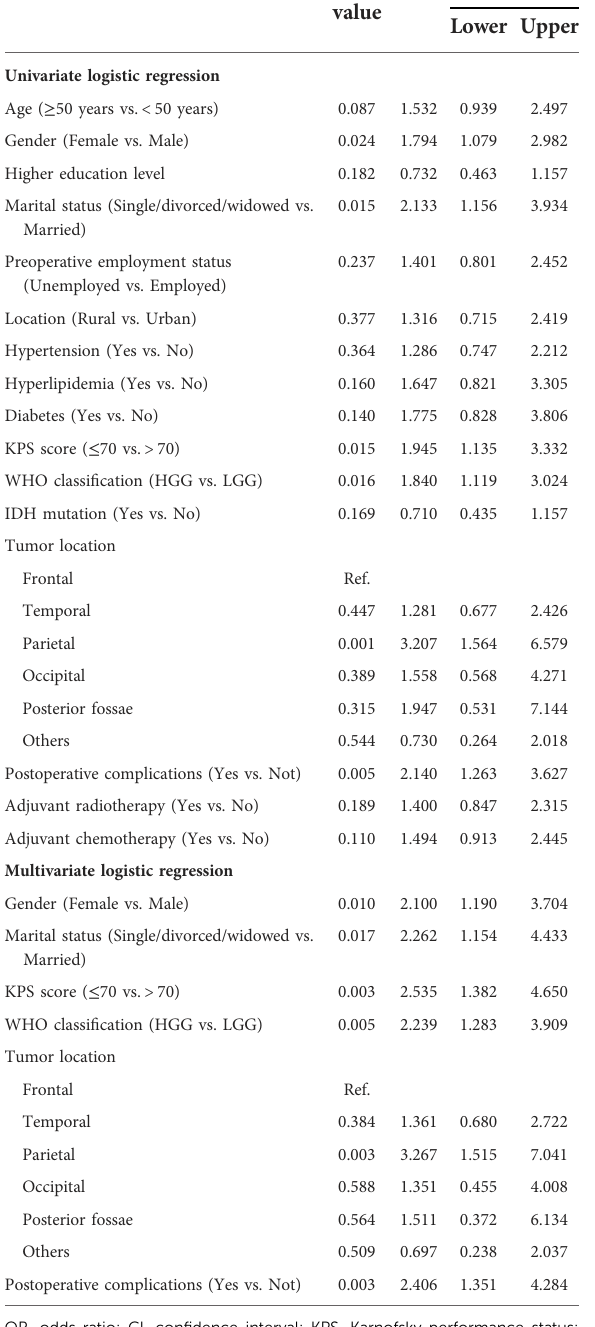
( Figure 4D ) was found among any time points in glioma patients. In addition, the last observation carried forward (LOCF) = 0.091) ( Supplementary Figure S1A ) and anxiety rate ( P = 0.594) ( Supplementary Figure S1B ) at different time points in moreover, HADS-D ( P = 0.024) ( Supplementary Figure S1C ) increased continually while there was no distinction of depression rate ( P = 0.931) ( Supplementary Figure S1D ) at different time points in glioma patients.